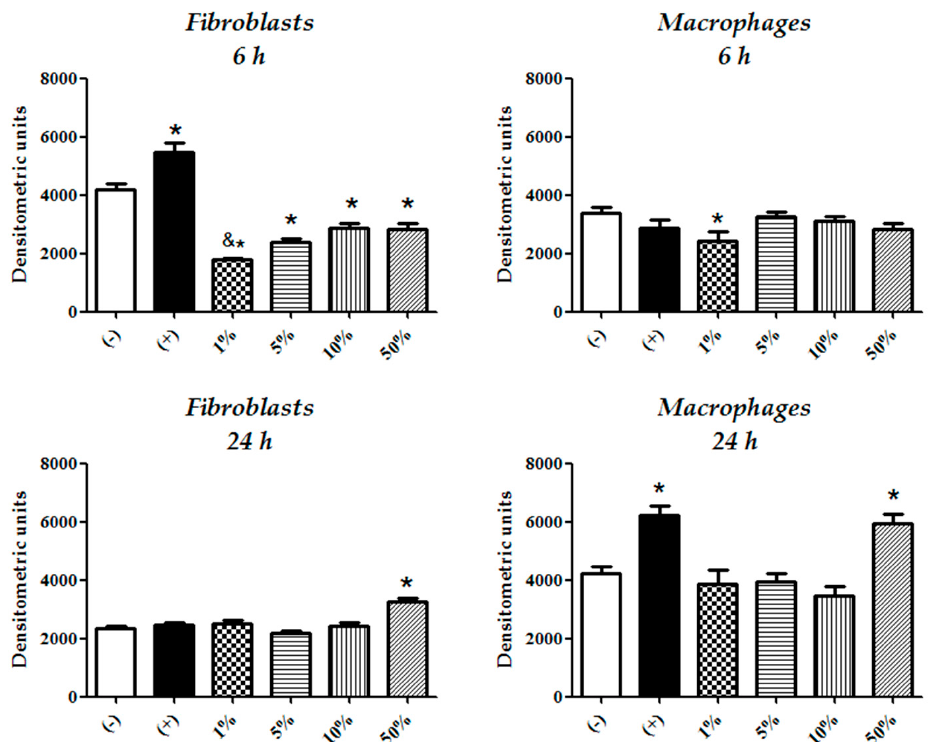
Figure 4. Assays of • O 2 − activity in fibroblast and macrophage cultures. MitoSOX fluorescence eval- uation was performed by image densitometric analysis (mean ± SD) from fibroblast and macrophage cultures after 6 h and 24 h of treatment with CFEAS. Results are shown for untreated cells ( − ; base cell oxidation), cells treated only with H 2 O 2 (+; positive control of oxidation due to the induction of the • O 2 − activity), and cells treated with 1–50% CFEAS. Statistically significant differences were observed between untreated cells ( − ) and fibroblast cultures treated for 6 h with 1–50% CFEAS (* p ≤ 0.05, control vs. 1, 5, 10, and 50%). One percent vs. 10 and 50% CFEAS also exhibited statistically significant differences ( p ≤ 0.05) in fibroblast cultures. After 24 h of fibroblast treatment, only 50% CFEAS was statistically significantly different from the control ( − ) (* p ≤ 0.05). Fibroblasts treated for 6 h with H 2 O 2 (+) exhibited a statistically significant difference when compared to untreated control ( − ) (* p ≤ 0.05). For macrophage response, after 6 and 24 h of treatment with 1% or 50% of CFEAS, respectively, statistically significant differences were seen when compared with untreated cells ( − ) (* p ≤ 0.05). Macrophages treated for 24 h with H 2 O 2 (+) exhibited a statistically significant difference when compared to untreated control ( − ) (* p ≤ 0.05). Differences in • O 2 − activity were assessed by one-way ANOVA analysis, and differences among cultures were evaluated using Bonferroni’s multiple-comparison test. * p or & p -values ≤ 0.05 were considered to be statistically